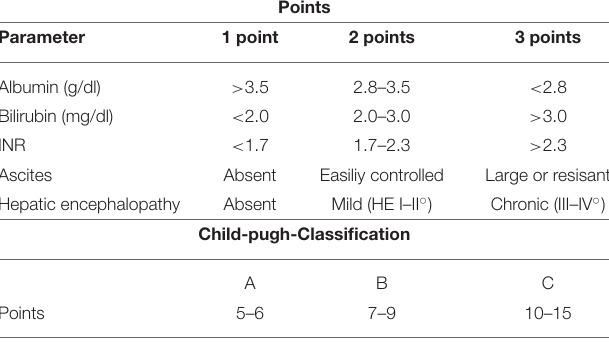
TABLE 6 | Child-Pugh-classification.